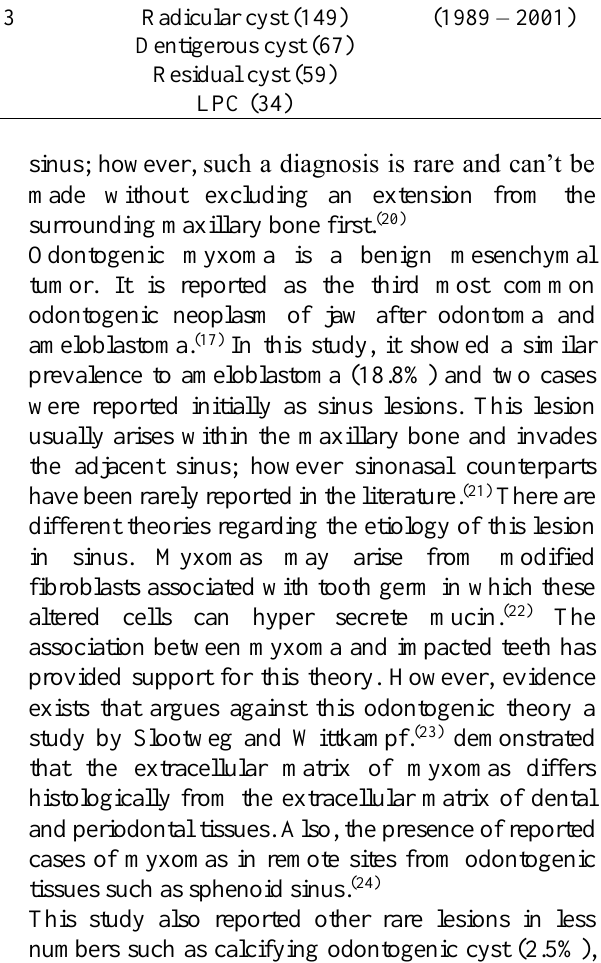
(Villasis-Sarmiento et al., 2017).